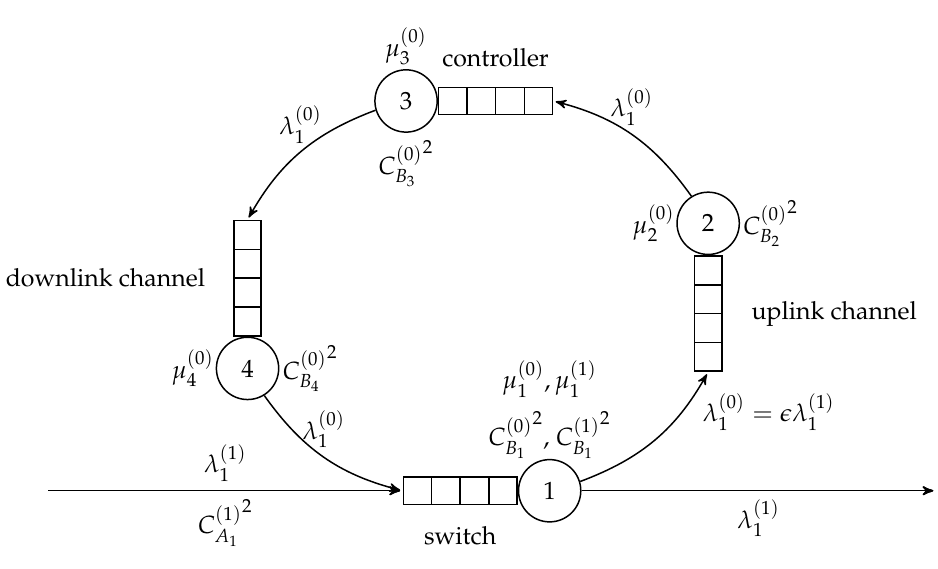
Figure 21. Model of SDN switch and its interactions with the SDN controller.